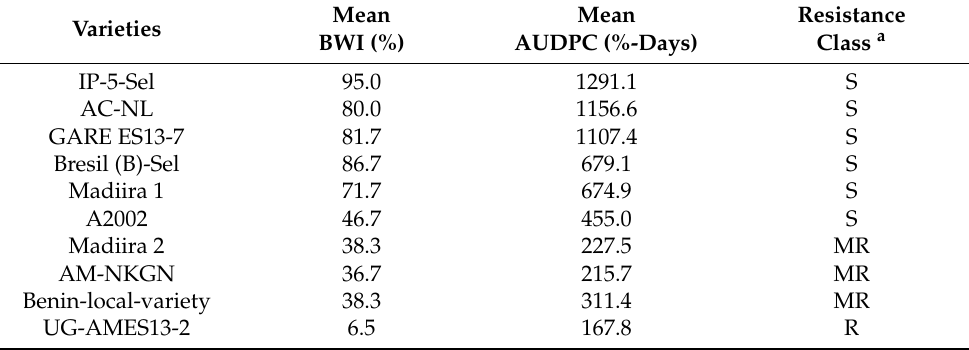
Table 4. Ranking of ten amaranth varieties according to bacterial wilt incidence (BWI) and the area under disease progress curve (AUDPC) based on screen house results.